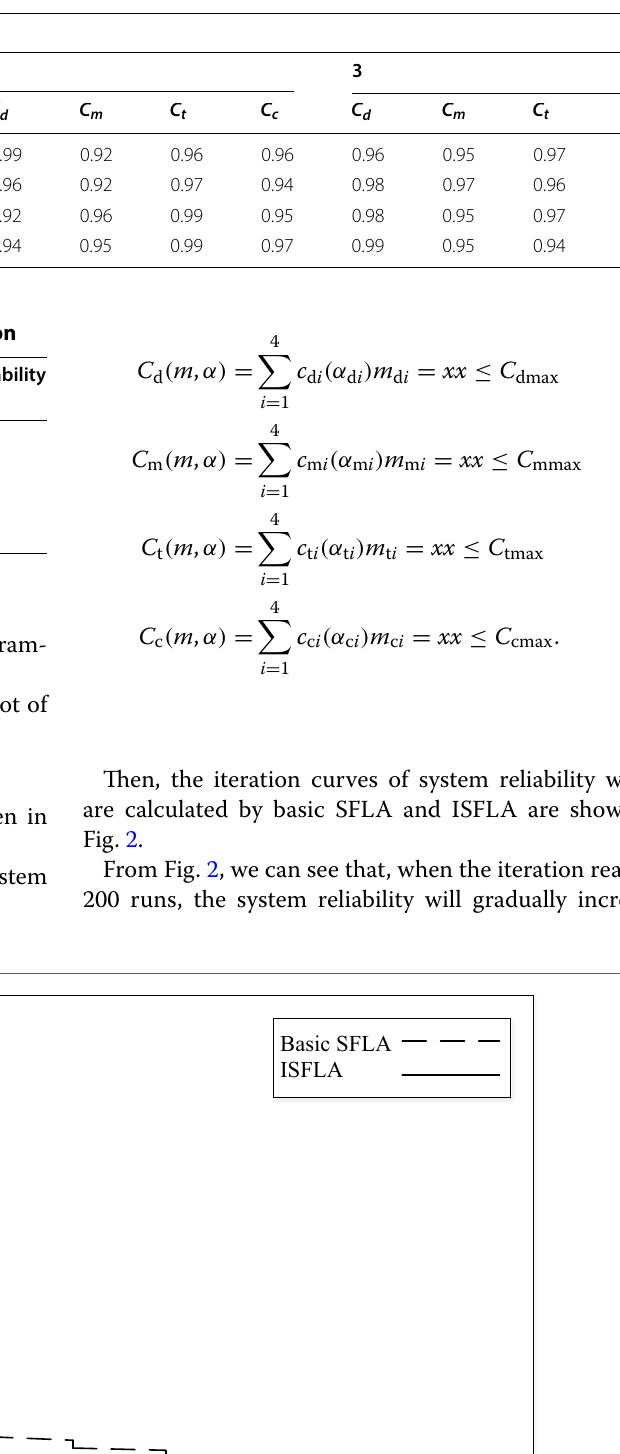
Table 2 System parameter values